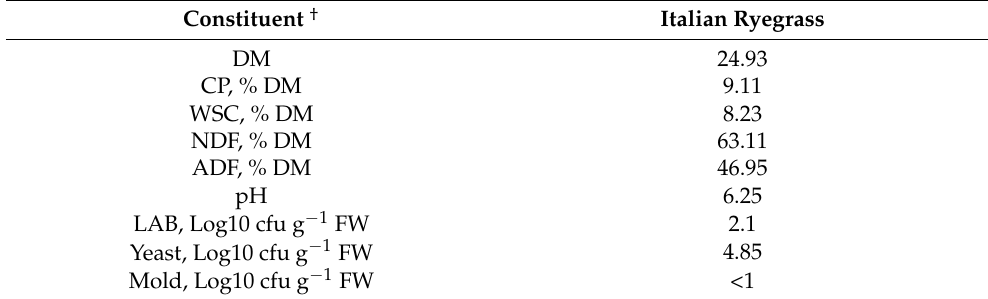
Table 1. Chemical composition and microbial populations of Italian ryegrass before